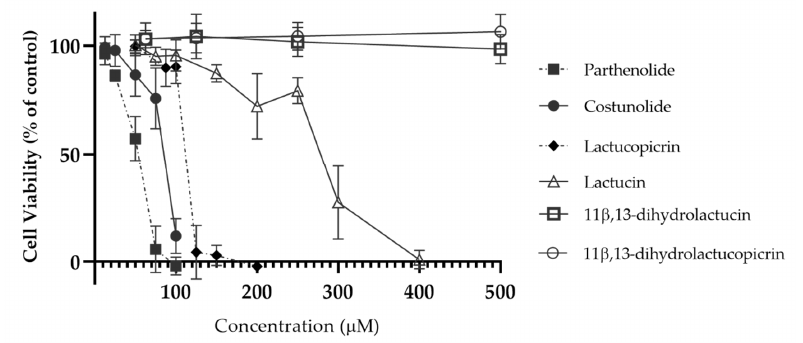
Figure 2. Cytotoxic profile of parthenolide, costunolide, lactucopicrin, lactucin, 11 β ,13-dihydrolactucin and 11 β ,13-dihydrolactucopicrin in Caco-2 cells. Cytotoxicity was evaluated using the PrestoBlue ® cell viability assay, by testing the compounds between 12.5 and 500 µ M. Data are presented as means ± SD, n =